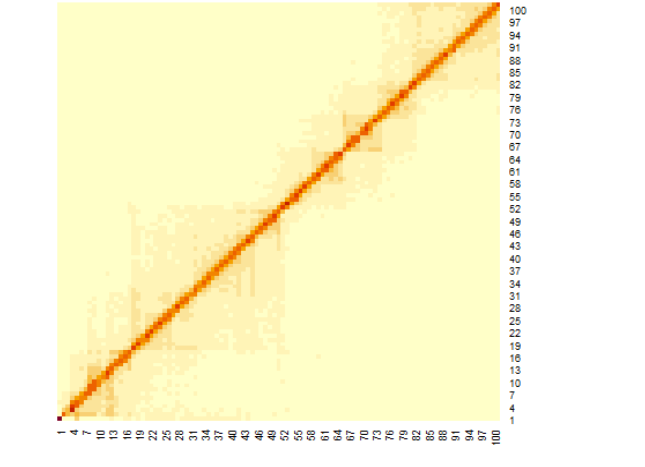
Figure 6. Heat map of 90 min Hi-C data of chromosomes 18 (0 bp–5000